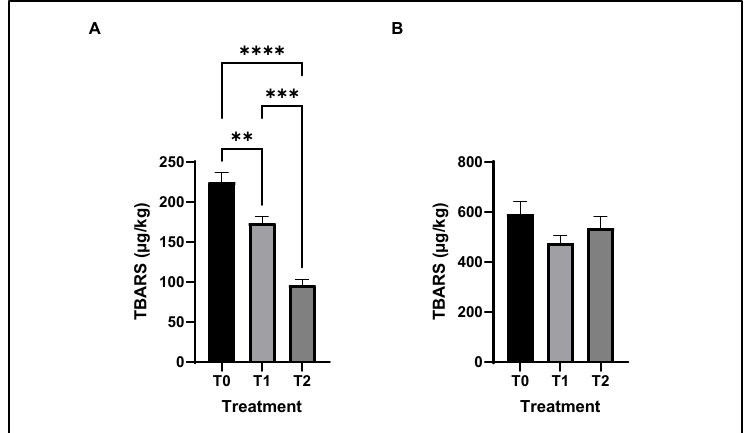
Figure 4. Bar graph illustrating lipid oxidation status (as TBARS, µg MDA/kg) of chicken breast ( A ) and thigh ( B ) after 7 days of storage. Asterisks denote statistical significance (** p ≤ 0.0021, *** p ≤ 0.0002, **** p < 0.0001); T0: control diet; T1: treatment with 0.00002% Cr; T2: experimental diet supplemented with 0.00002% Cr +2% sea buckthorn leaves (SBL), ns = non‑significant.